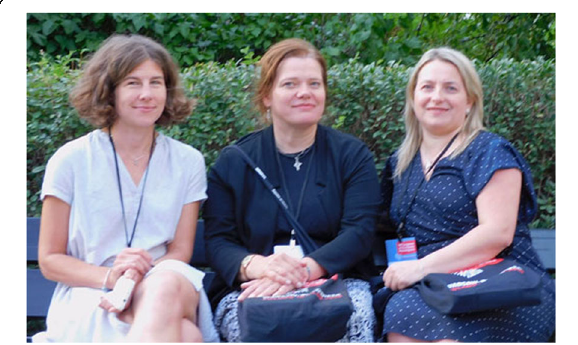
Fig. 4 The CEM local organizing committee: Julia Paw ł owska ( left